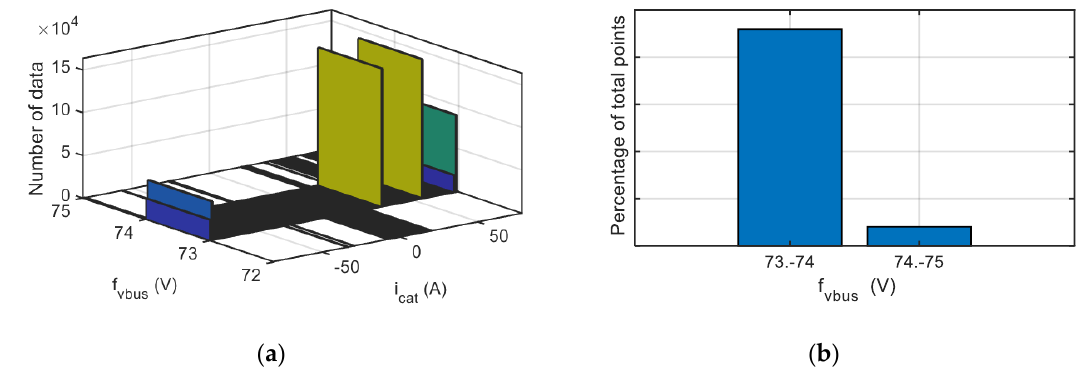
Figure 18. Visualization for an offset fault injected in DC-link voltage sensor. (a) Histogram. (b) Percentage of points for each fault reconstruction interval.